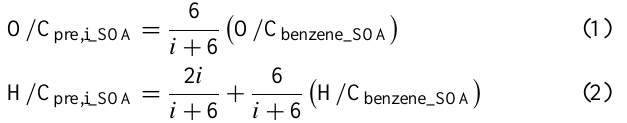
ratios as they do in the aromatic precursor ( − CH 3 dilution ef-